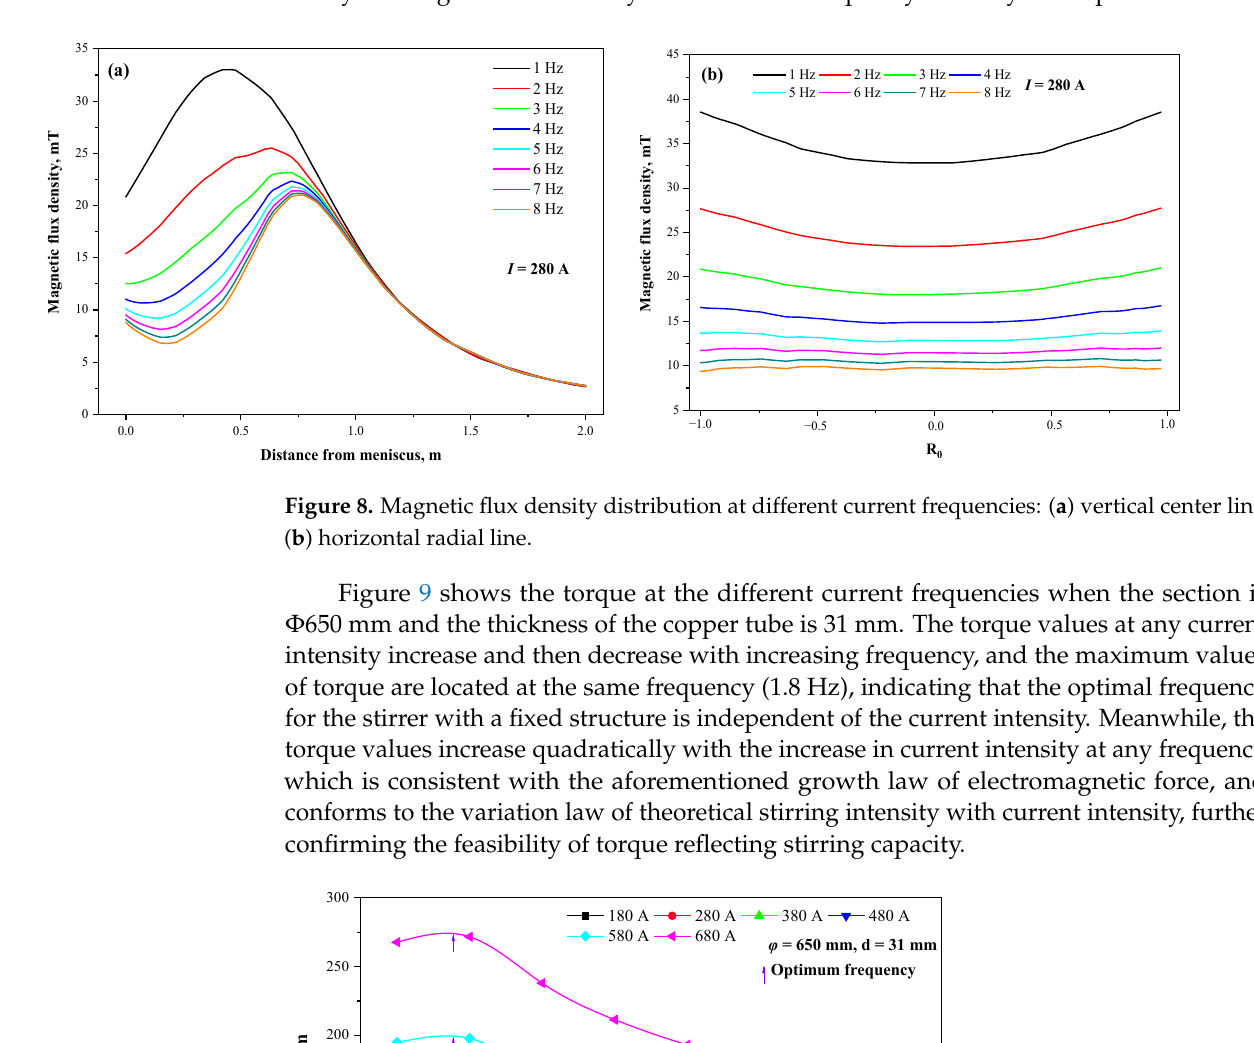
1.0 −− − − − Figure 7. Distribution of electromagnetic forces on radial lines at different current intensities. Figure 8 indicates the distribution of magnetic flux density on the center axis and horizontal radial line of the stirrer at the different current frequencies when the section is Φ650 mm and the current intensity is 280 A. In fact, according to Abe ’s law, the current frequency does not affect the magnetic flux density, and the magnetic shielding effect is quite obvious at the copper tube thickness of 31 mm, so the magnetic flux density at the same location decreases with the increase in current frequency. The position of the maxi-